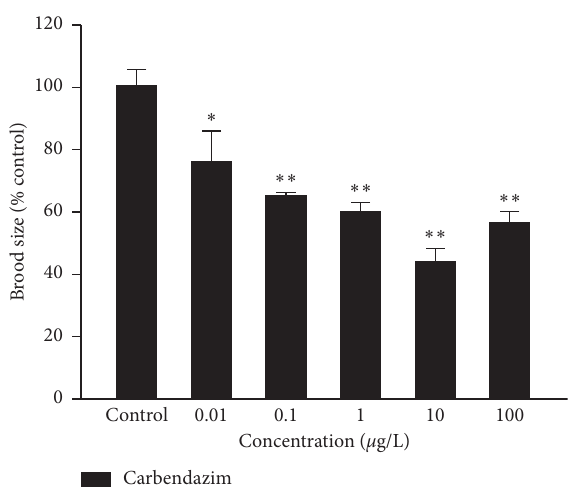
Figure 2: Effects of C. elegans on brood size exposed to carben- dazim. Data (mean ± SEM) are shown as the percentage value compared with the control group. The asterisks present the sig- nificance between the each exposure group and control group ( ∗ p < 0 . 05 and ∗∗ p < 0 . 01).